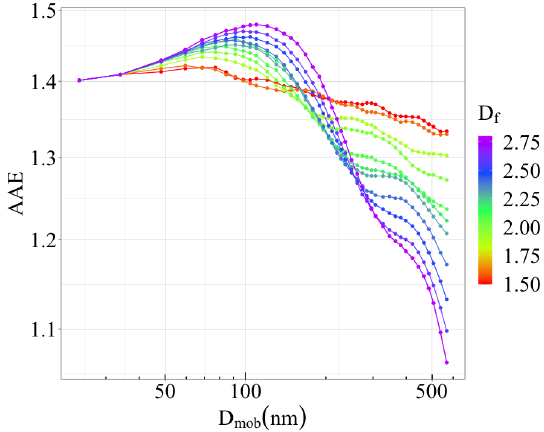
Figure 12. Ångström absorption exponent (AAE) of pure BCFAs ( f coating = 0%) with changing fractal dimension ( D f ) and mobility diameter ( D mob